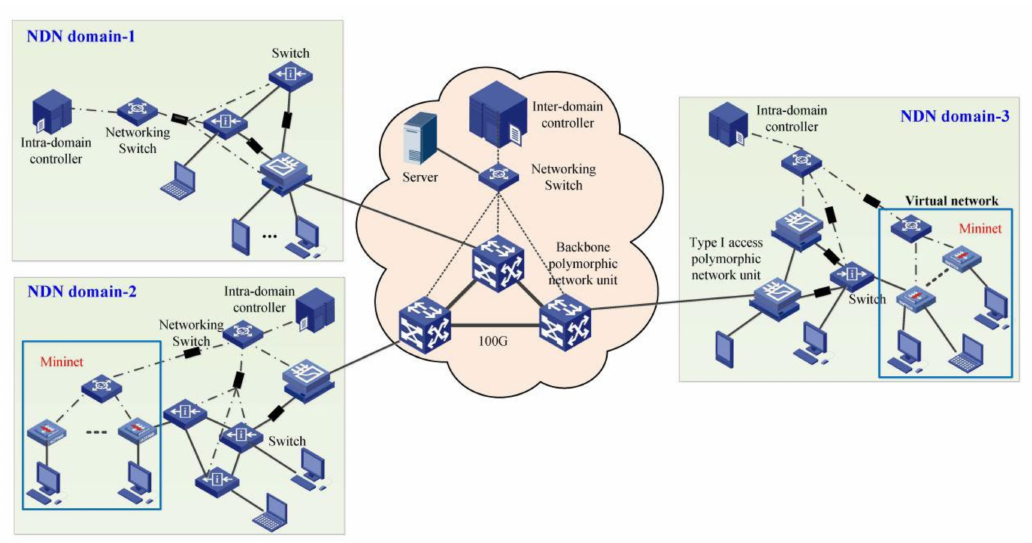
Figure 4. The topology of the experiment.